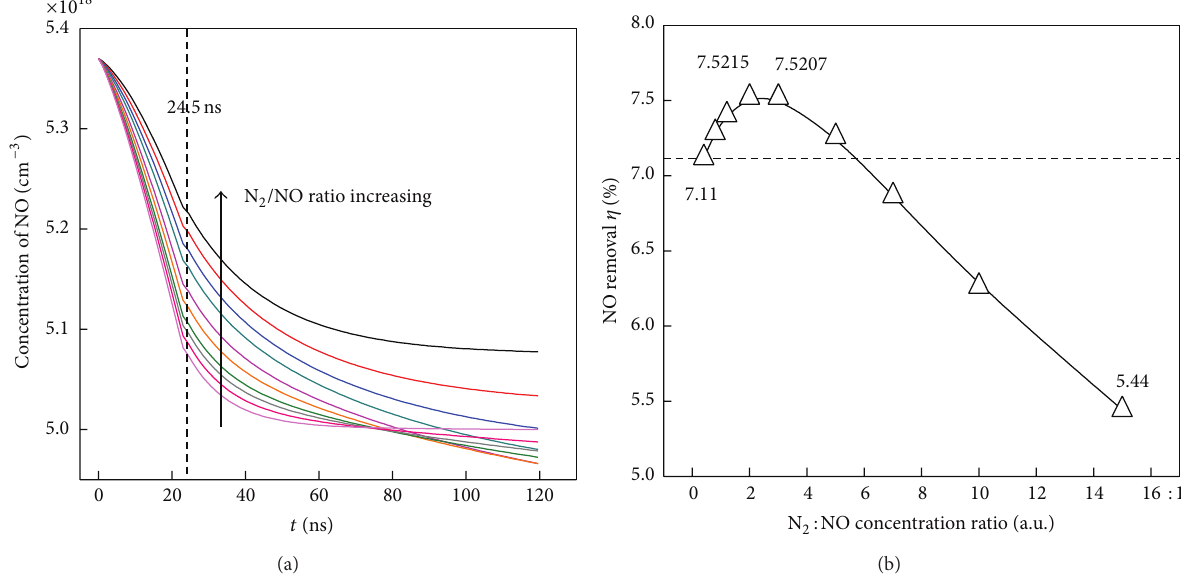
Figure 11: (a) The time evolution of NO concentration under different NO/N 2 ratio; (b) NO removal percentage under different NO/N 2 ratio.